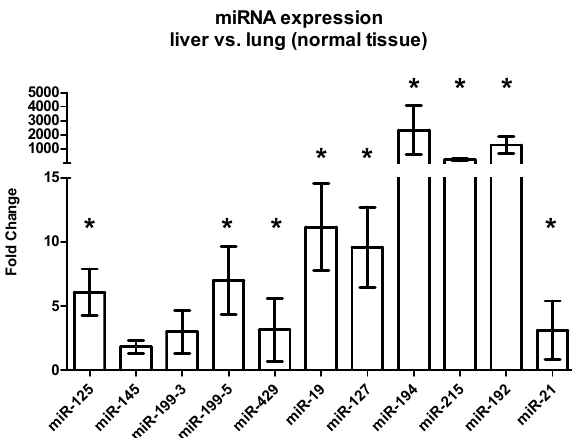
Figure 3. Differential expression between the host tissue of colorectal liver and lung metastases. The graph shows the mean fold change with the standard error of the mean SEM ( ΔΔ C t -Method) of the host tissue in the liver metastases compared to the expression of the host tissue in the lung metastases. p -values were calculated using the t -test. Significant expression differences are marked with an asterisk (*).